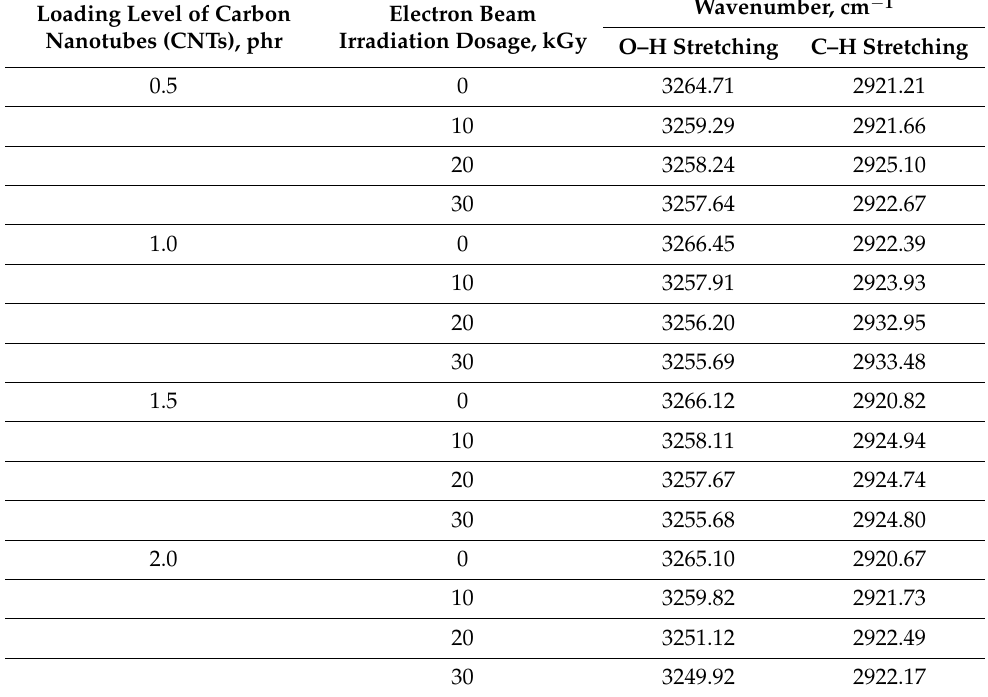
Table 2. Wavenumber of O–H stretching and C–H stretching of all carbon nanotubes added polyvinyl alcohol (PVOH) nanocomposites when subjected to various electron beam irradiation